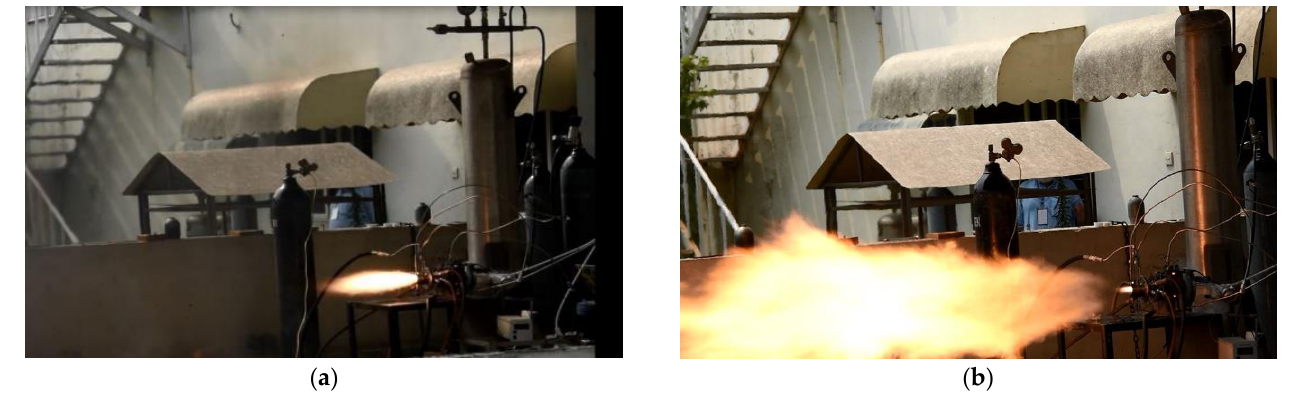
Figure 17. Exhaust plume of GG: ( a ) without secondary combustion; ( b ) with secondary combus- tion.